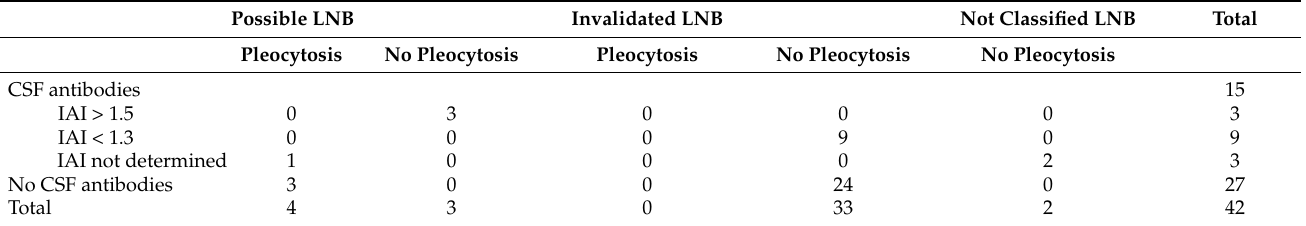
Table 2. LNB classification according to CSF analyses of pleocytosis and intrathecal B. burgdorferi antibody